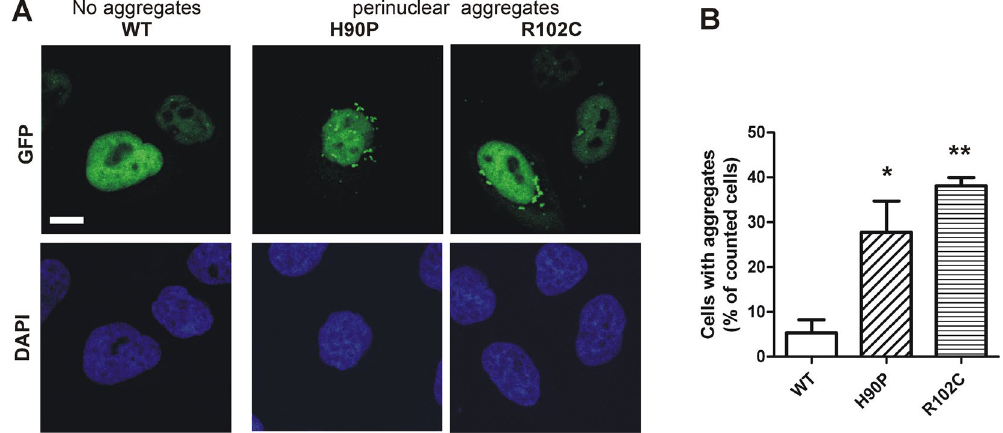
Figure 6. Detection of GFP-DYRK1B aggregates by fluorescence microscopy. GFP fluorescence was observed by confocal laser scanning microscopy two days after HeLa cells were transfected with expression plasmids for wild type or mutant GFP-DYRK1B. Panel A shows representative images of cells with and without aggregates. The percentage of cells with visible aggregates was determined in 3 independent experiments (panel B , means and SD). Statistical significance of the differences between WT and mutant DYRK1B was tested using paired Student’s t-test ( * p < 0.05, ** p < 0.01). Scale bar, 10 µ m; DAPI, staining of nuclear DNA with 4 ′ ,6-diamidino-2-